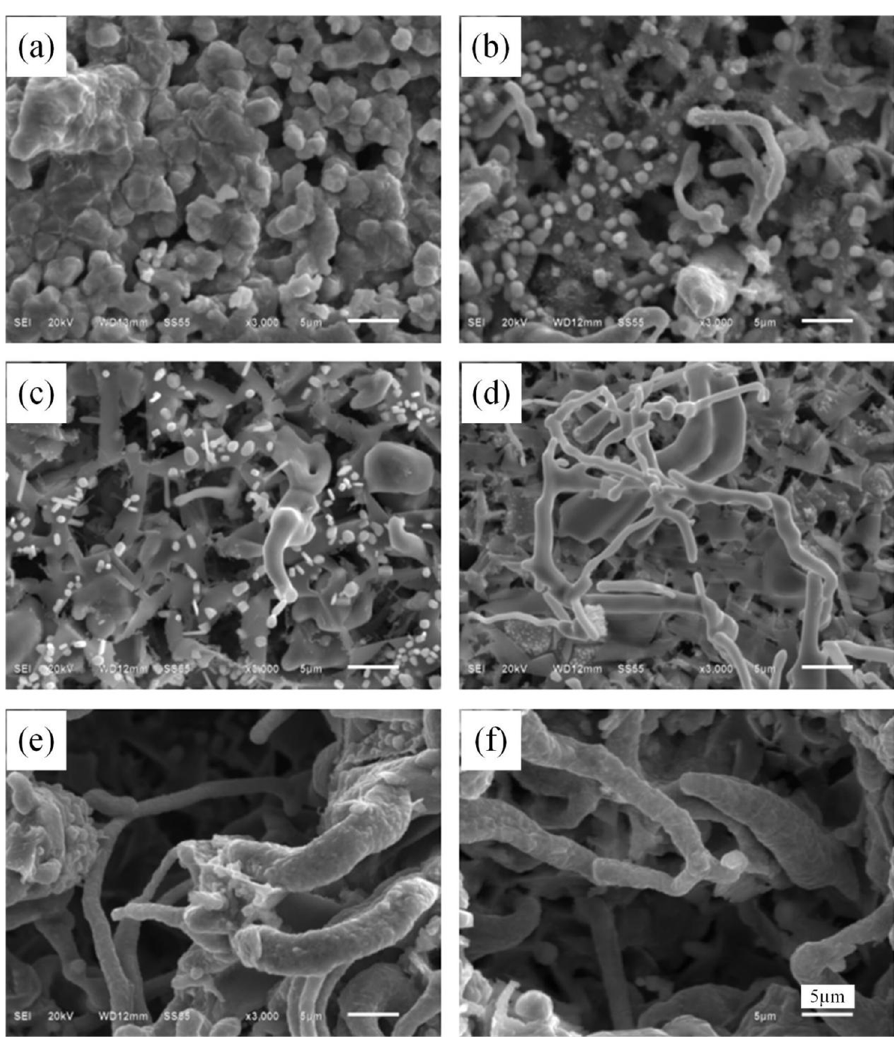
Figure 14: SEM image of reduced briquettes with di ff erent basicity reduced for 60 min: ( a ) basicity = 0, ( b ) basicity = 0.33, ( c ) basicity = 0.67, ( d ) basicity = 0.83, ( e ) basicity = 1.0, and ( f ) basicity =